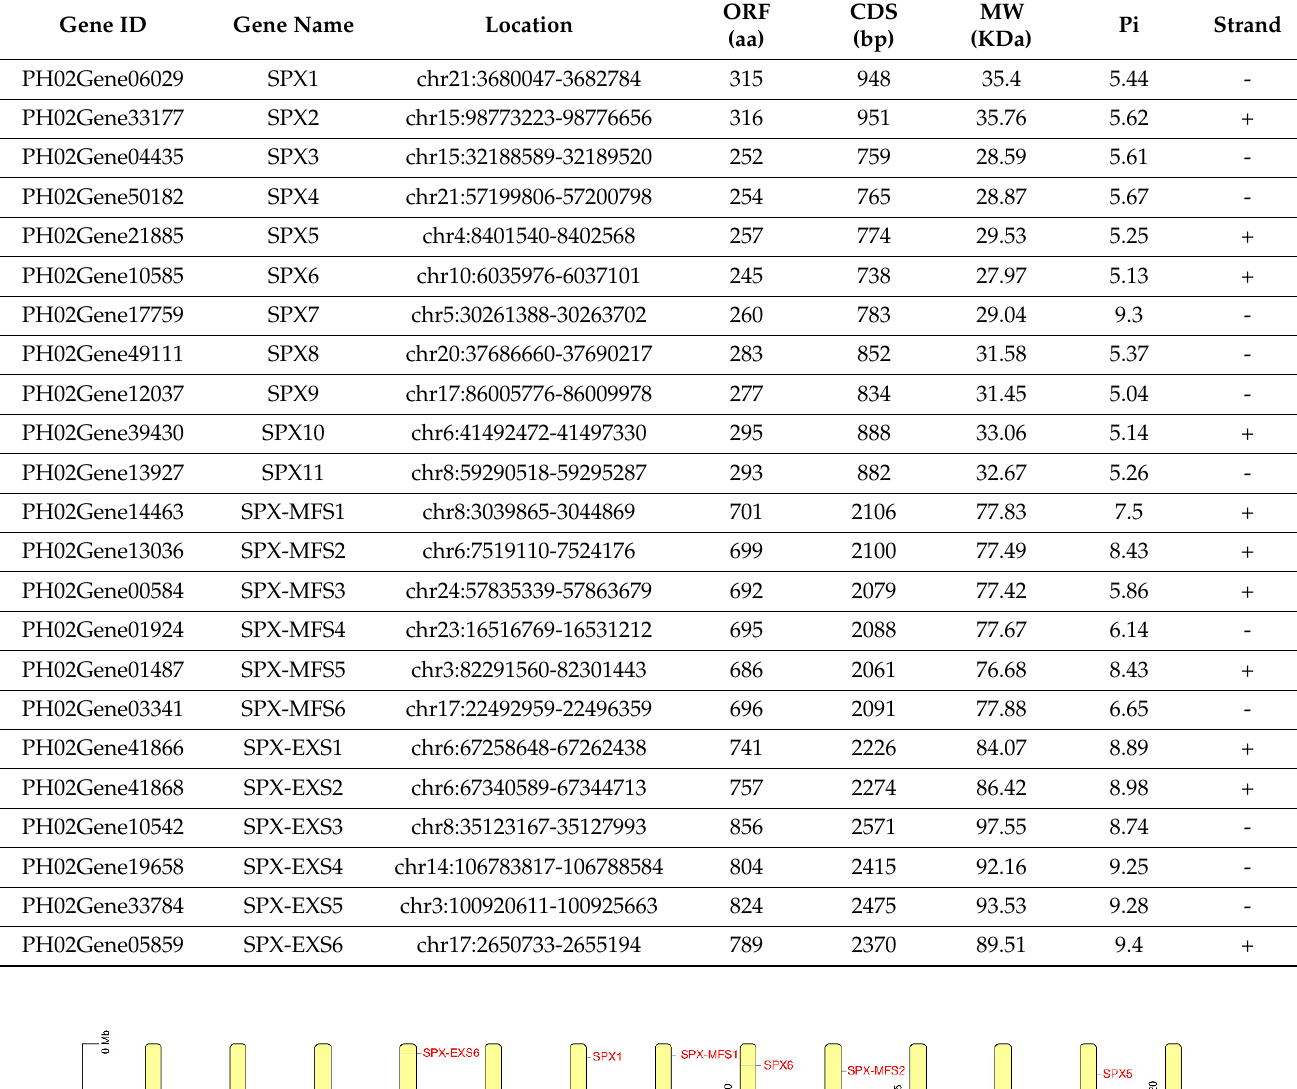
Table 1. Description of Phyllostachys edulis SPX-domain-containing proteins family genes.